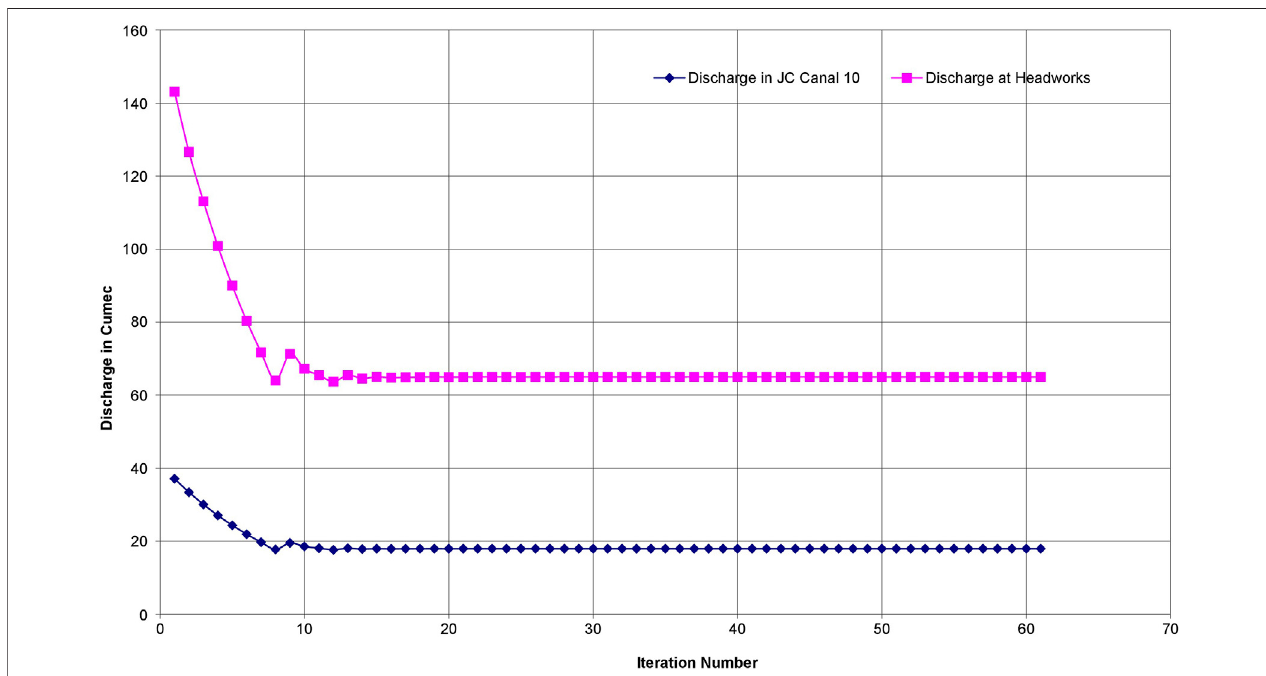
FIGURE 5 | Convergence characteristic for initial assumption in JC Canal 10 at design discharge.